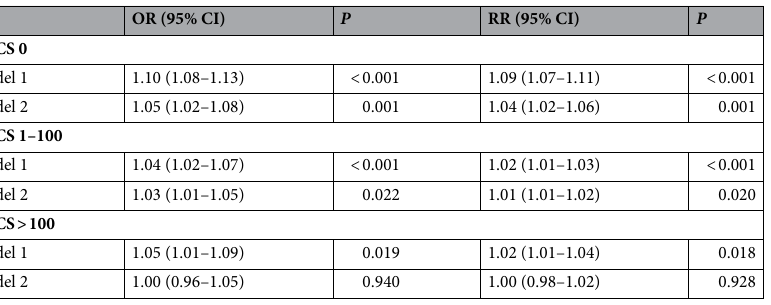
Table 3. Impact of the AIP (per 0.1-unit increase) on CAC progression, beyond traditional risk factors, according to baseline categorical CACS. Models: 1 = unadjusted; 2 = adjusted for age, sex, and the traditional risk factors of hypertension, diabetes, hyperlipidemia, obesity, and current smoking. AIP atherogenic index of plasma, BMI body mass index, CAC coronary artery calcification, CACS coronary artery calcium score, CI confidence interval, OR odds ratio, RR relative